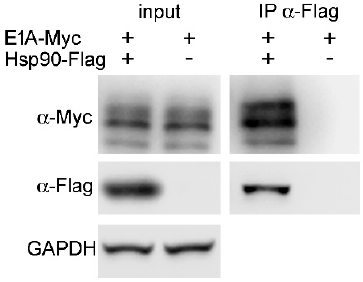
Figure 8. E1A 289R interacts with Hsp90 α . HEK293 cells were transfected with plasmids that expressed E1A 289R-Myc and E46A mutant of Hsp90 α -Flag as indicated. Flag specific antibody was used for immunoprecipitation. Cell extracts (input) and proteins bound to anti-Flag antibody (IP α -Flag) were probed with anti-Flag, or anti-Myc antibodies, to detect Hsp90 α and E1A 289R respectively. Representative western blot, one of two performed is shown.